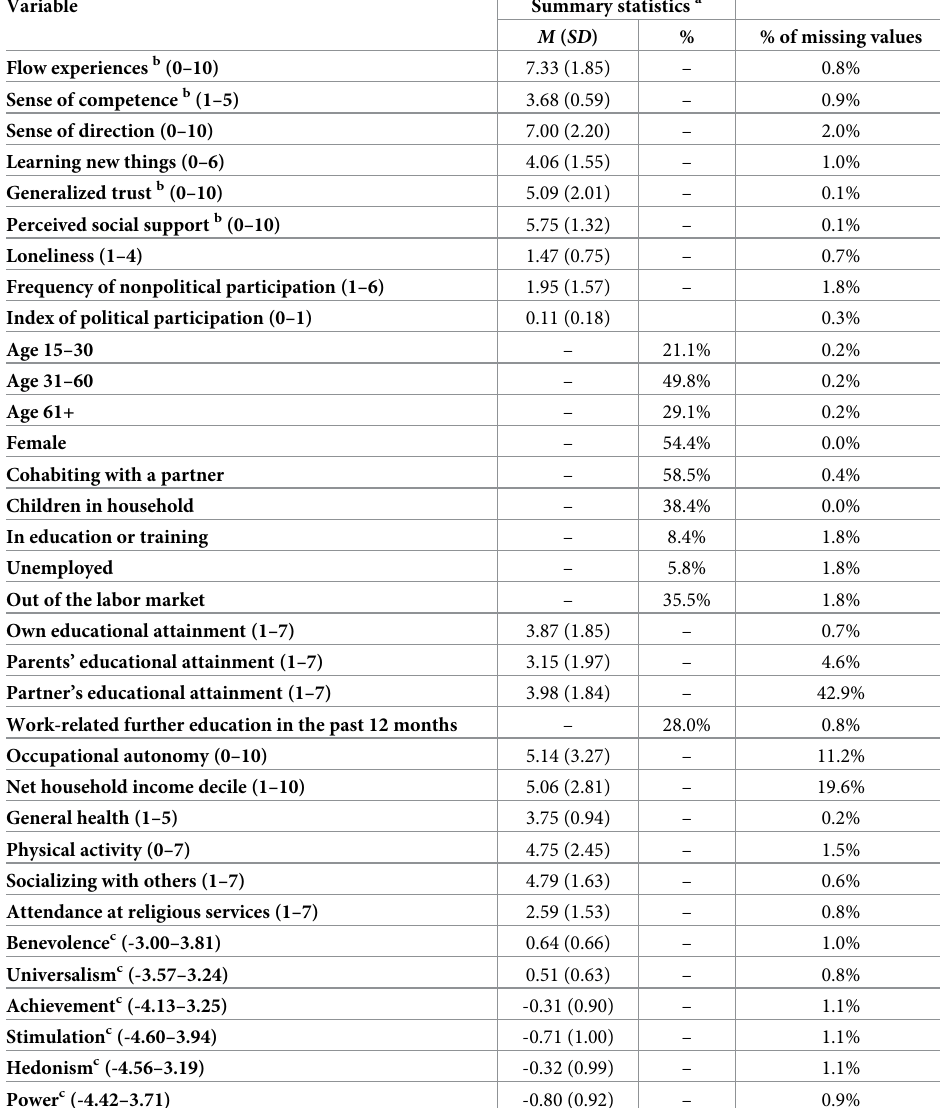
Table 2. Descriptive statistics for the central study variables at the individual level (Study